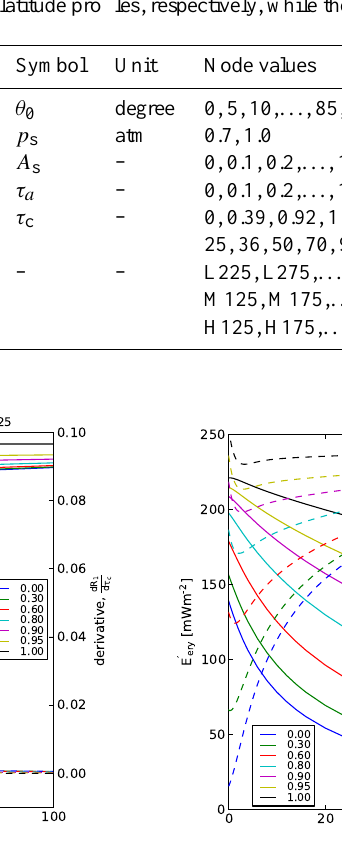
Figure 5. Typical dependence of the erythemal dose rate on cloud optical depth for different surface albedos (solid lines, left y axis) together with the relative derivative (dashed lines, right y axis) in- dicating the percent change in the dose rate for a unit change in the cloud optical depth. Symbols are defined in Table